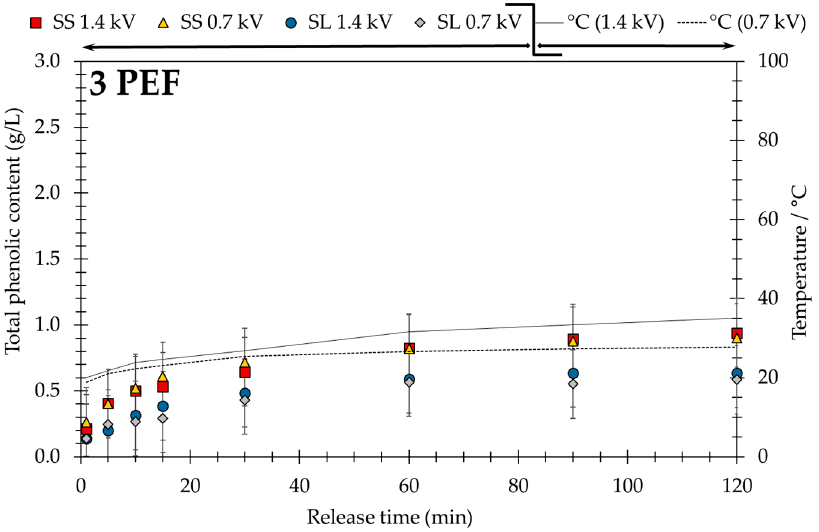
Figure 5. Extraction kinetics (left axis) and measured temperature curves (right axis) using pulsed electric field (PEF).